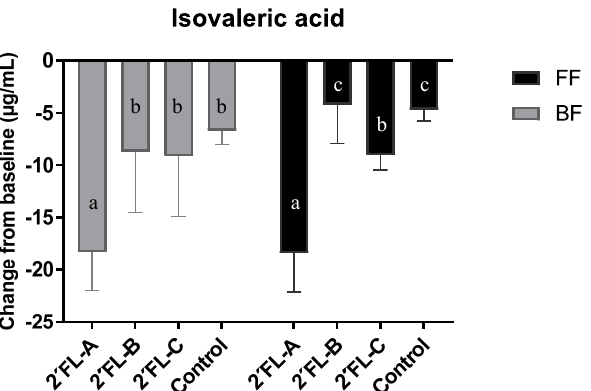
Figure 4. Variations in the levels of isovaleric acid with respect to values in baseline (time 0) after 24 h of incubation in fecal cultures of three BF and three FF infant donors. Different letters in bars indicate significant differences ( p < 0.05) among the three 2 (cid:48) FL commercial preparations and controls analyzed separately in cultures of FF and BF infants.